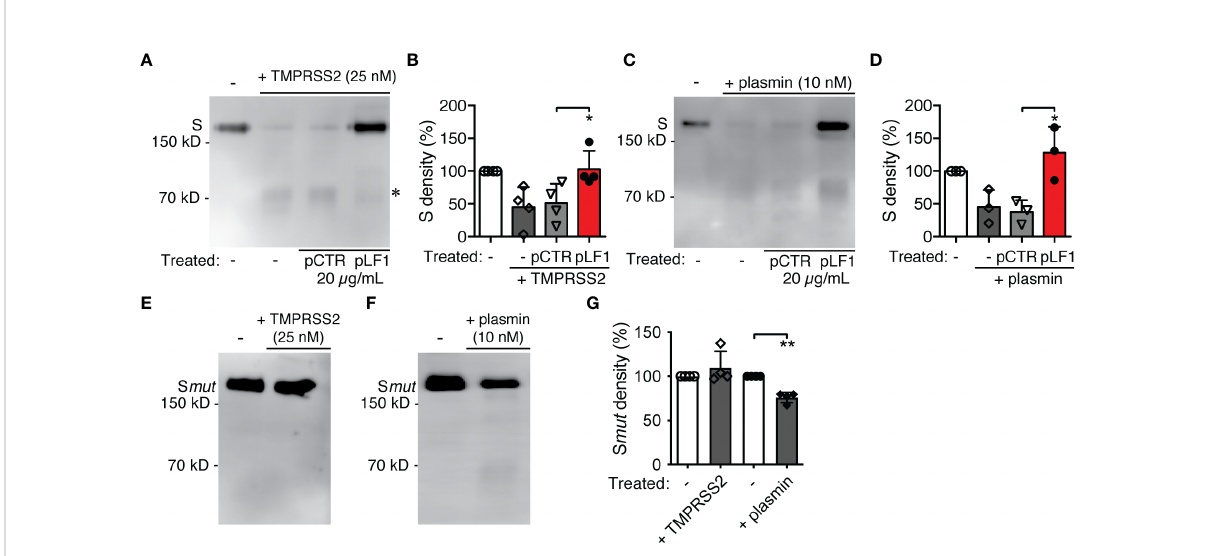
FIGURE 2 Effect of LF and the LF-derived peptides on SARS-CoV-2 S protein proteolytic processing. (A) The puri fi ed recombinant 6x-His-tagged S protein was exposed to TMPRSS2 with or without pLF1 or pCTR at 37°C in Tris-HCl buffer for 2 h. The digestion of the S protein was analyzed by immunoblotting of the reaction mixtures followed by an incubation with the speci fi c anti-6x-His mAb. Upon cleavage by TMPRSS2, a digestion product of the S protein of about 75 kD became visible (marked by *). (B) Densitometric quanti fi cations of the proteolytic processing of the S protein by TMPRSS2. Peptide pCTR served as a control. Four independent immunoblotting experiments were evaluated. The bands corresponding to the full-length S protein in the absence of TMPRSS2 were set as a relative maximum of 100%. The immunoblots were quanti fi ed by the AzureSpot software. (C) Puri fi ed recombinant 6x-His-tagged S protein was exposed to plasmin instead of TMPRSS2 and treated afterwards as in (A) . (D) Densitometric quanti fi cations of the proteolytic processing of the S protein by plasmin. Peptide pCTR served as a control. Densitometric evaluation of three independent immunoblotting experiments was performed as in (B) . (E-G) The puri fi ed recombinant 8x-His-tagged mutated S protein was treated in in vitro proteolysis assay with TMPRSS2 (E) and plasmin (F) as in (A, C) , and the cleavage (G) was evaluated as in (B, D) Values of p*<0.05, p**<0.005 (as indicated) were considered to be signi fi